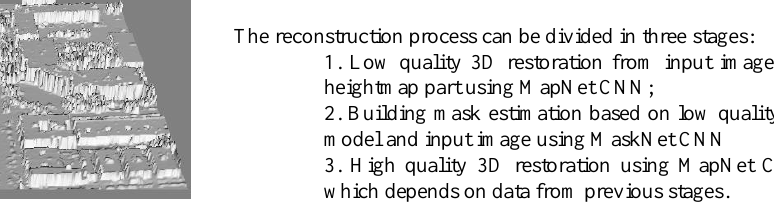
Figure 2. Heightmap (left) and corresponding cityscape 3D model